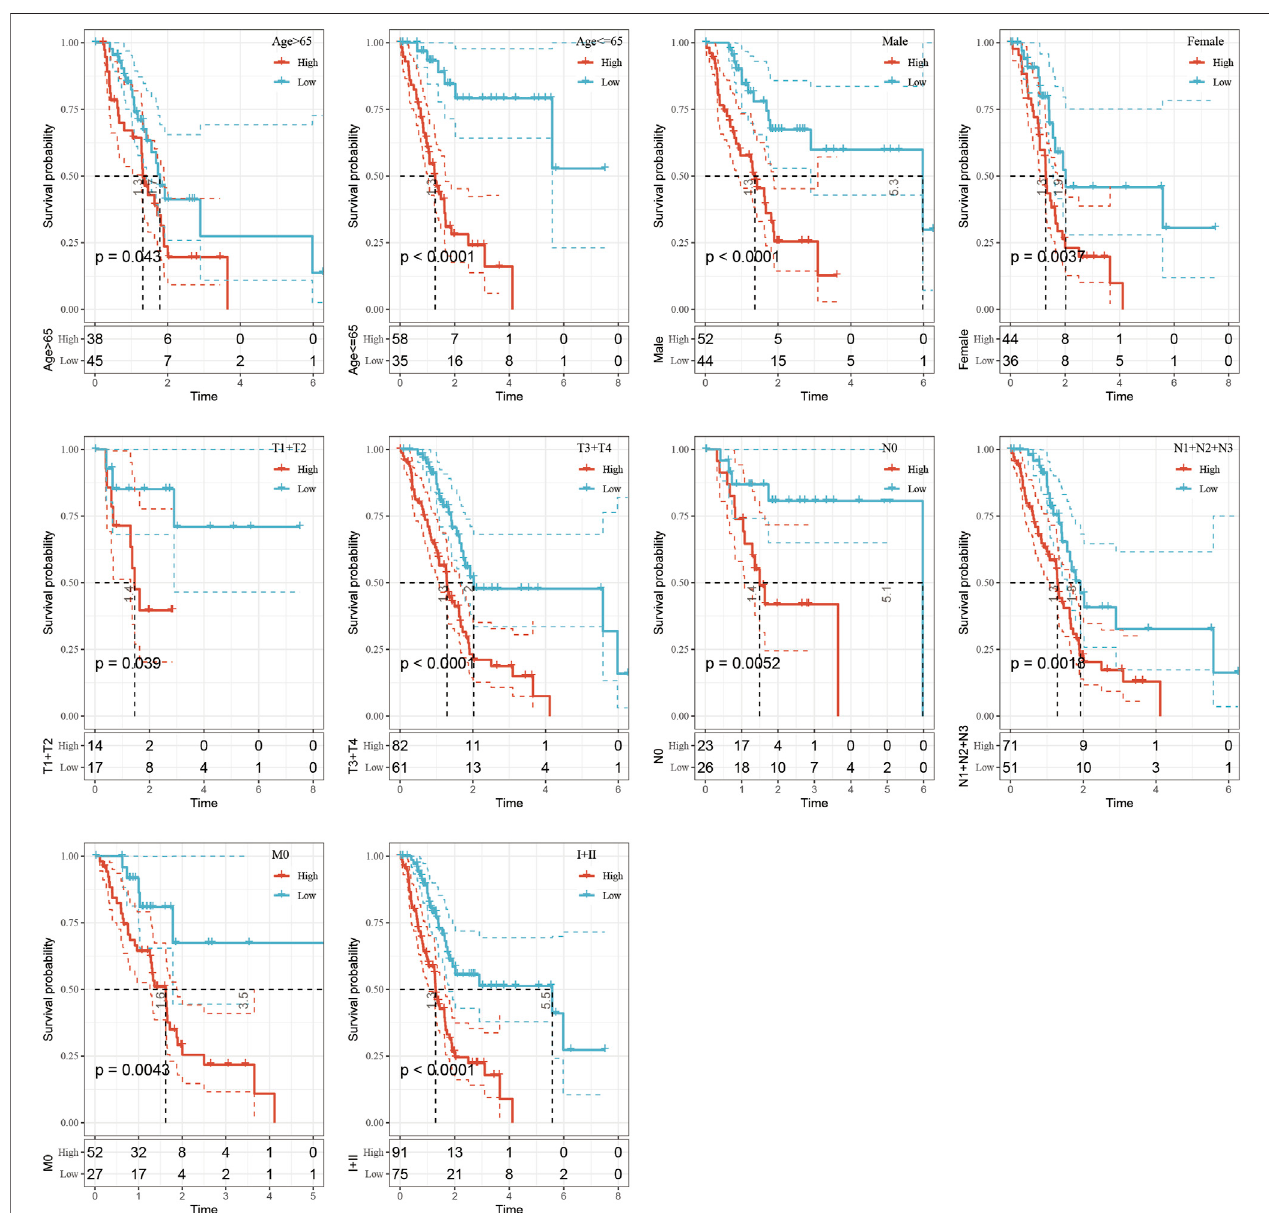
FIGURE 8 | Performance of the prognostic risk model for different clinical